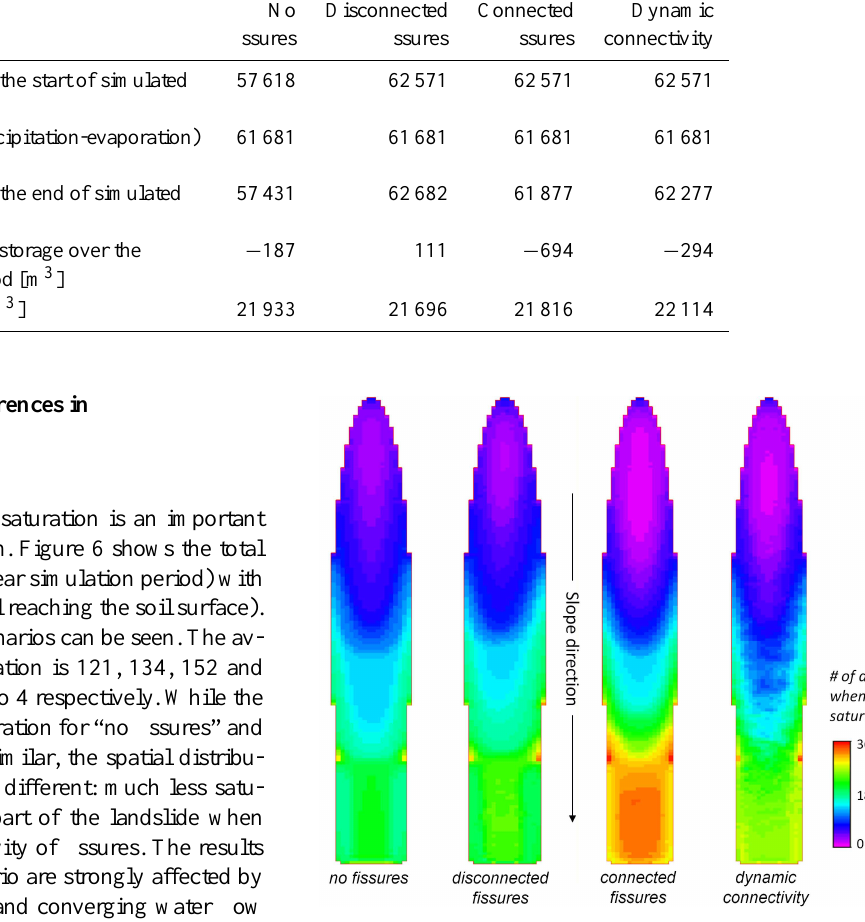
Fig. 6. The total number of days during one-year simulation period that full saturation was